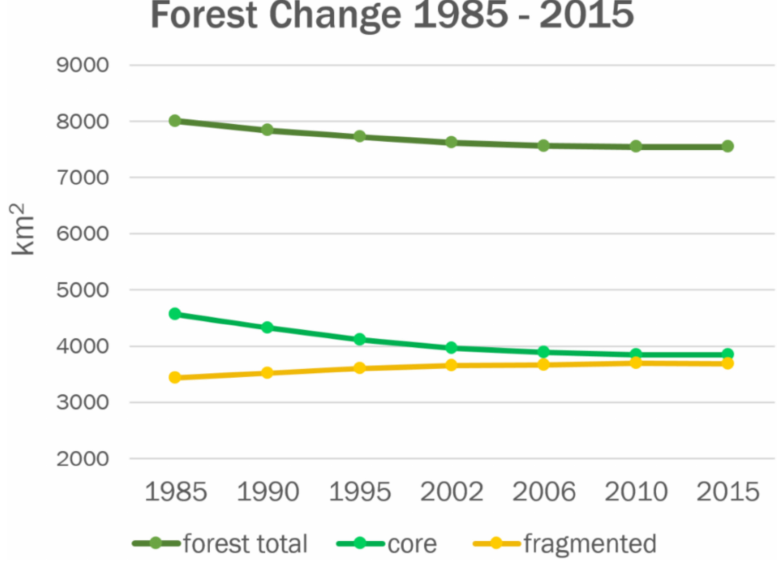
Figure 17. Change in total forest cover, core forest, and fragmented forest (3 categories combined) over project